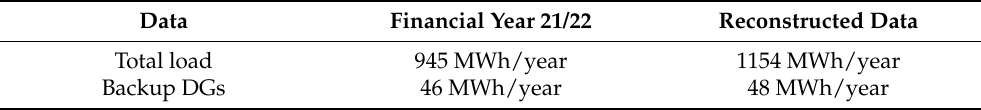
Table 2. Comparison of final energy consumption and production in the financial year 2021–2022 and reconstructed